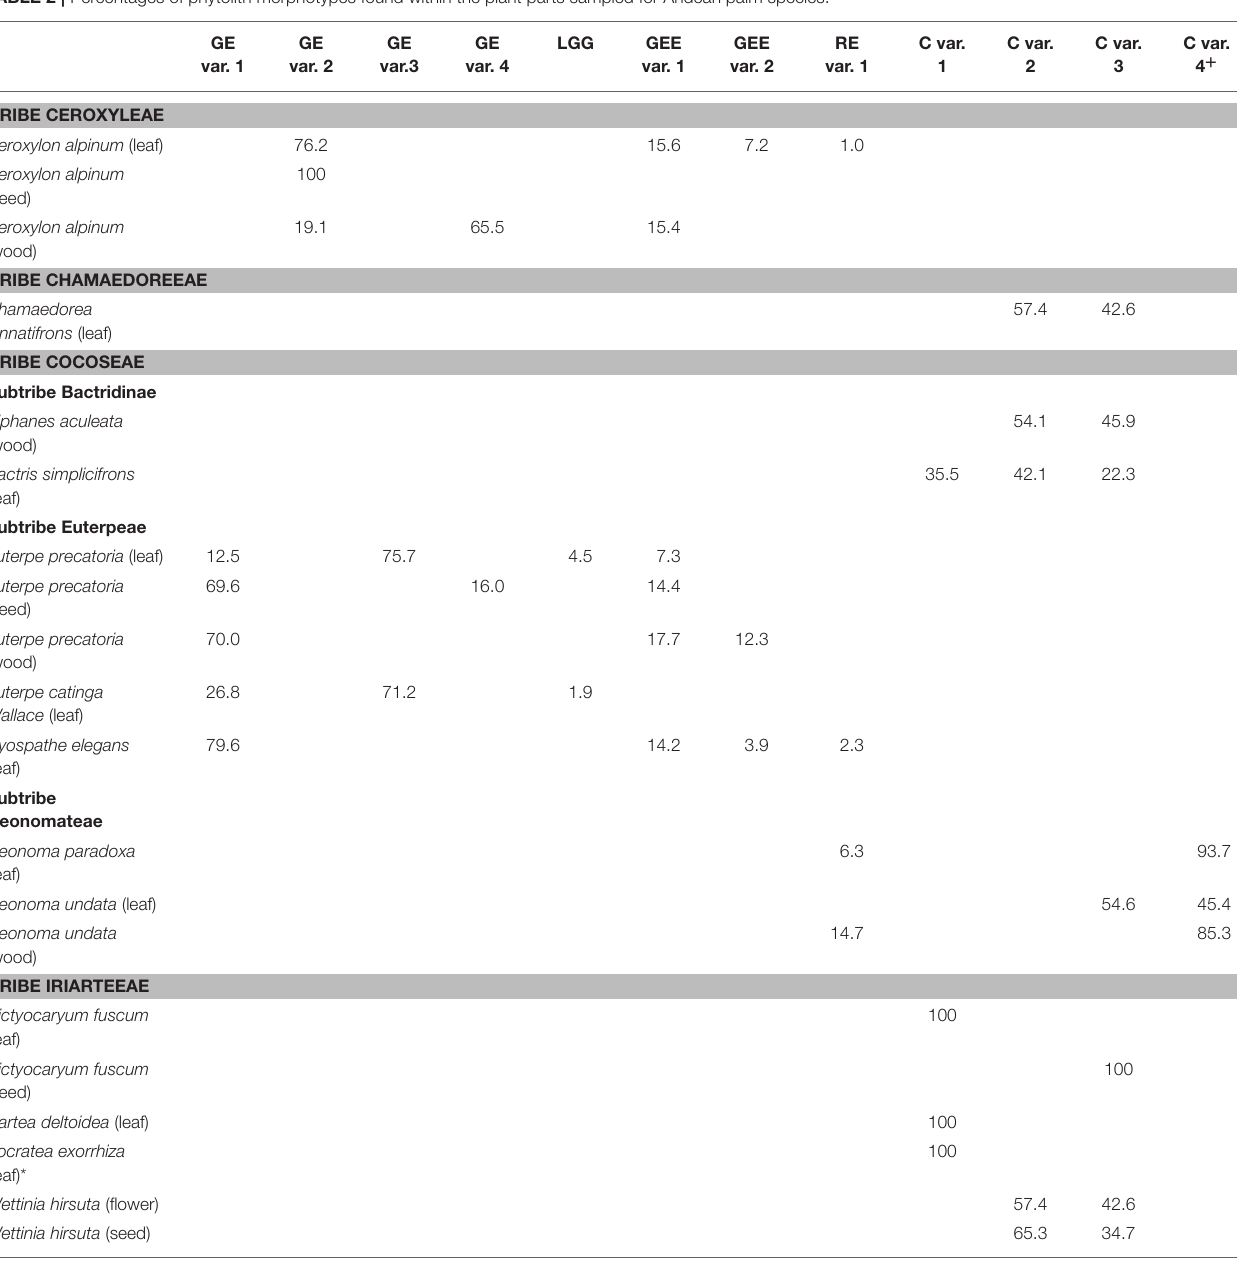
TABLE 2 | Percentages of phytolith morphotypes found within the plant parts sampled for Andean palm